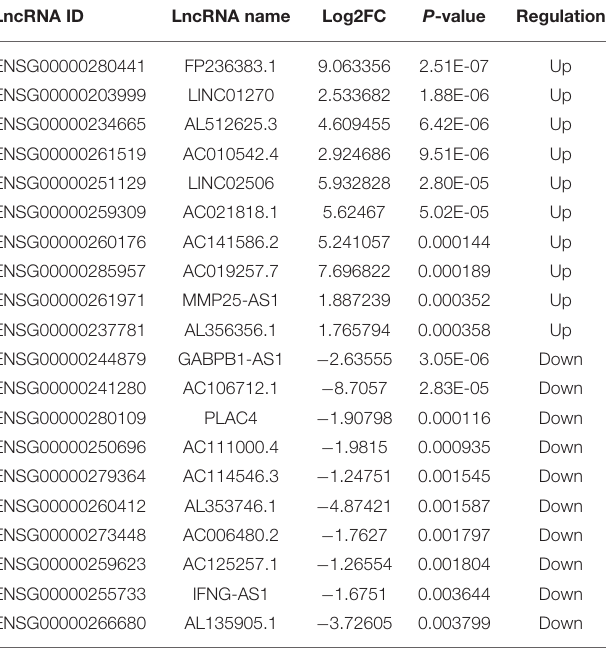
TABLE 5 | Top 10 up- and down-regulated differentially expressed mRNAs in HF vs.